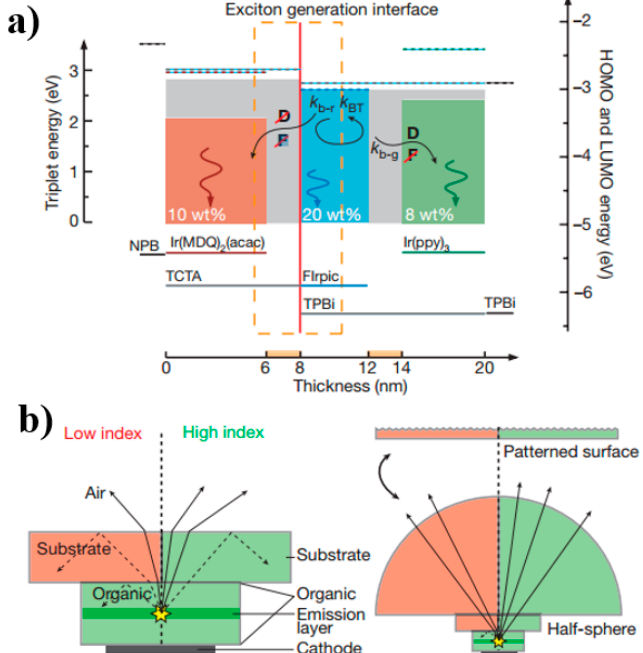
Figure 11. ( a ) Device structure of the WOLED and the proposed energy level. ( b ) Left: a cross-section of an OLED to illustrate the light propagation. Solid lines indicate modes escaping the device to the forward hemisphere; dashed lines represent trapped modes. Right: a large half-sphere and a patterned surface can be applied to increase light outcoupling. Reproduced from Reference [134].